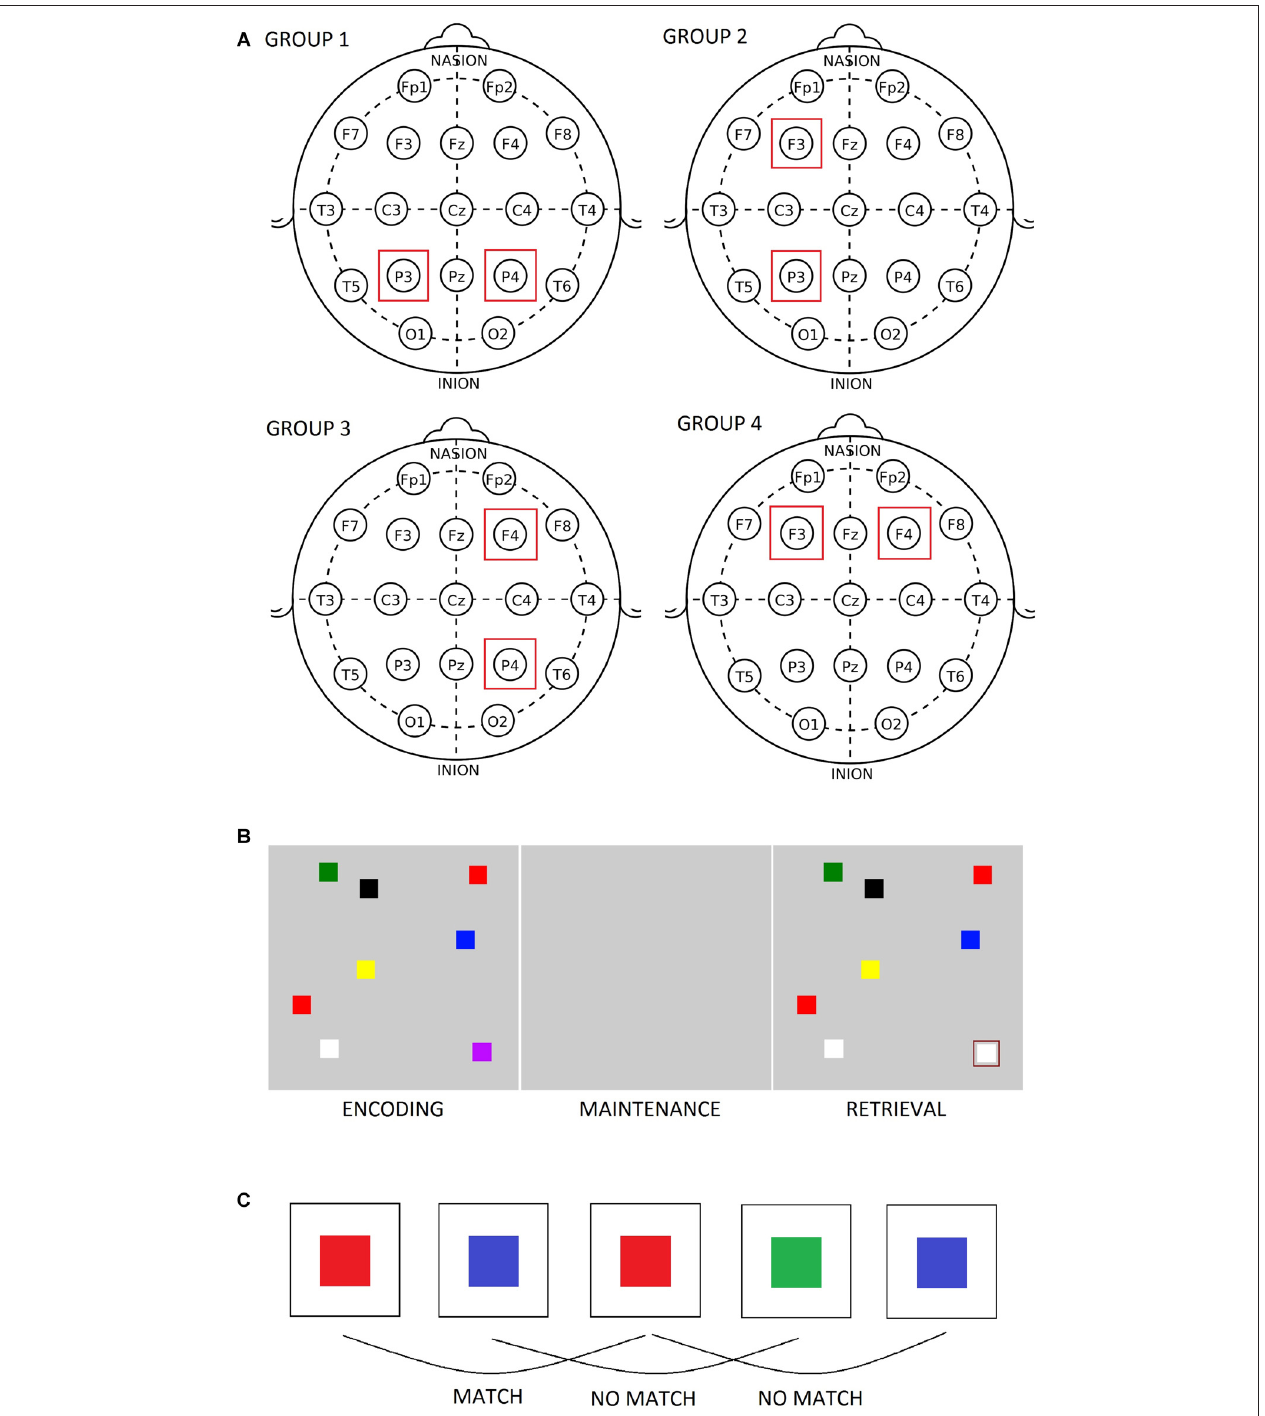
FIGURE 1 | (A) Position of transcranial alternating current stimulation (tACS) electrodes in the four groups. (B) The figural change detection task. (C) The figural 2-back task.